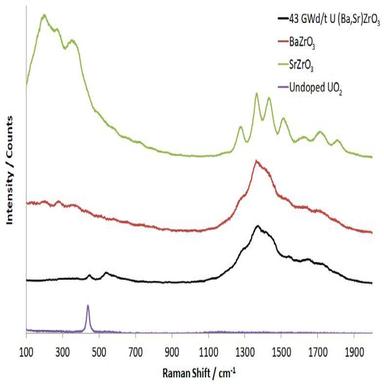
μRaman spectra of pressed powders of BaZrO3 and SrZrO3, an undoped UO2 pellet sample and a (Ba,Sr)ZrO3 precipitate phase in a 43 GWd/tU AGR SIMFuel sample.